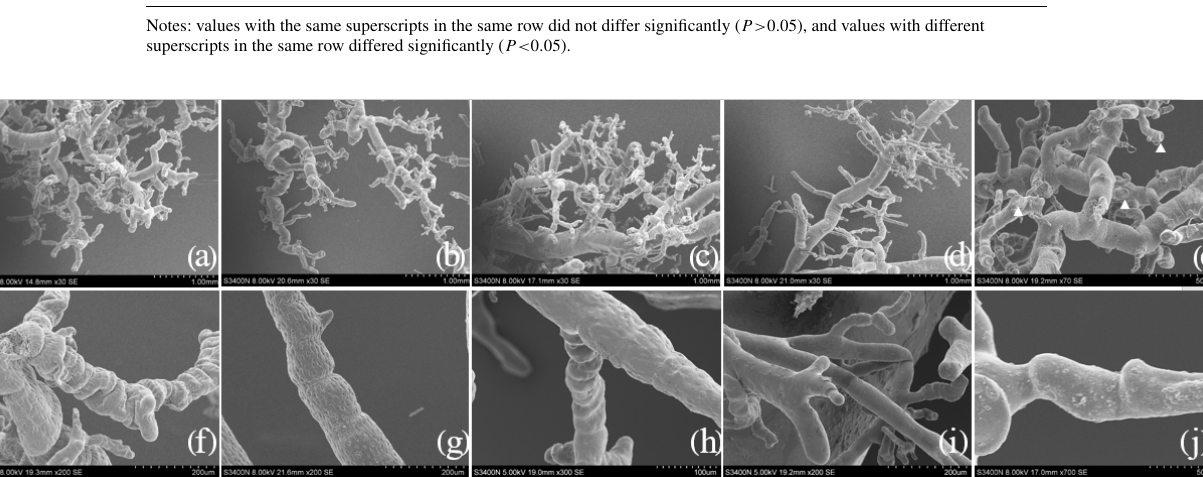
Figure 3. Distribution and superficial features of the arterioles in the left lung. (a) The arteriole distribution of the LYD group ( × 30). (b) The arteriole distribution of the TGN group ( × 20). (c) The arteriole distribution of the TJC group ( × 30). (d) The arteriole distribution of the LJC group ( × 30). (e) Microvascular terminal, with a triangle mark ( × 70). (f) Imprints of the endothelial nuclei of the LYD group ( × 200). (g) Imprints of the endothelial nuclei of the TGN group ( × 200). (h) Imprints of the endothelial nuclei of the TJC group ( × 300). (i) Imprints of the endothelial nuclei of the LJC group ( × 200). (j) Precapillary arterioles ( ×